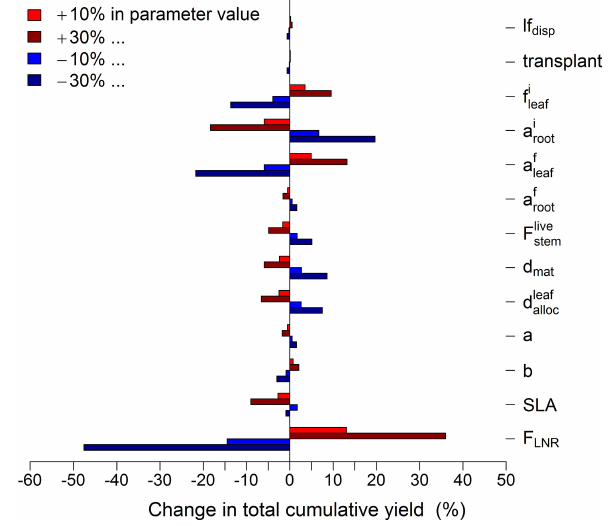
Figure 8. Sensitivity analysis of key allocation parameters in regard of the cumulative yield at the end of simulation, with two magni- tudes of change in the value of a parameter one by one while others are held at the baseline values in Table